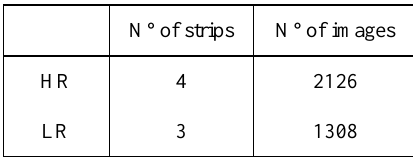
Table 3. Terrestrial photogrammetric